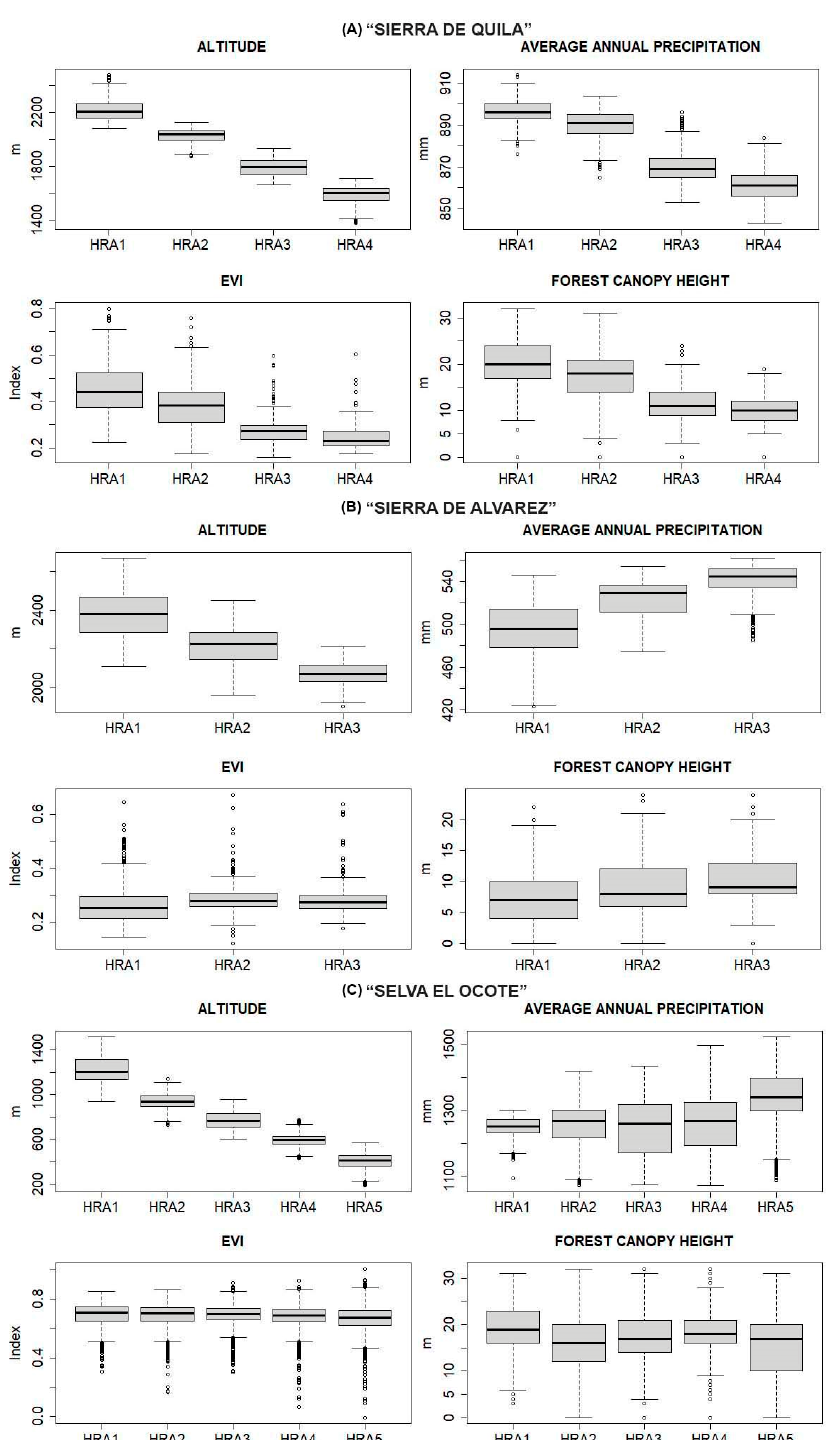
Figure 3. Boxplot showing quartiles of altitude (m asl); average annual precipitation (mm); enhanced vegetation index (EVI) and forest canopy height (m) by HRAs in ( A ) “Sierra de Quila,” ( B ) “Sierra de Álvarez” and ( C ) “Selva El Ocote,” p -value < 0.05 according to Kruskal Wallis test.